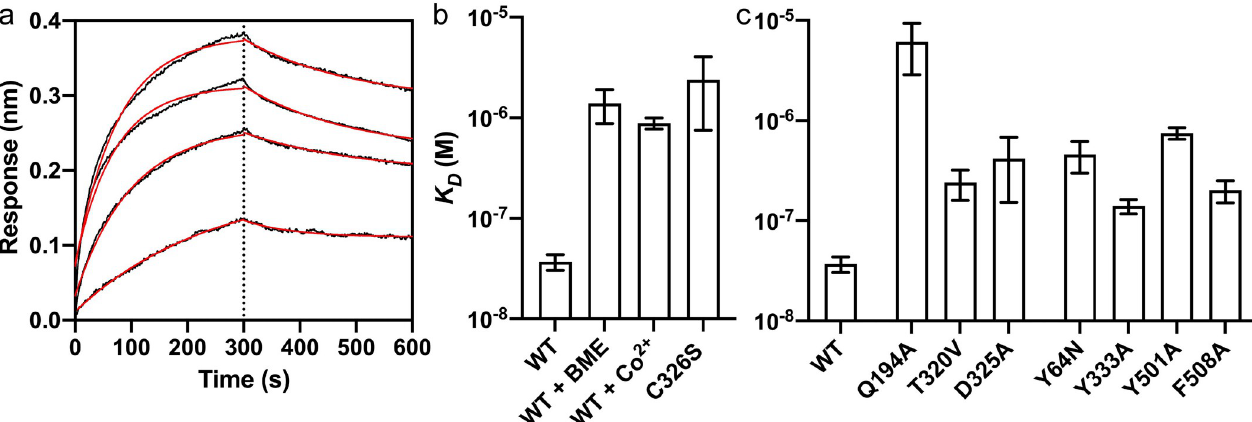
Fig 6. Binding of PR73 to Fpn. ( a ) Octet traces of WT Fpn in the presence of 1.25, 2.5, 5, and 10 μ M PR73. The average K D is approximately 37 nM. ( b ) Binding affinity of HsFpn to PR73 in different conditions, the presence of 5 mM BME, 5 mM Co 2+ , or the Cys326Ser mutant. ( c ) Binding affinity of HsFpn mutants to PR73. The height of the bars represents the mean of at least 3 measurements ( n = 3) and the error bars the SEM. Source data for ( a – c ) can be found in S1 Data . BME, β -mercaptoethanol; SEM, standard error of the mean; WT, wild type.